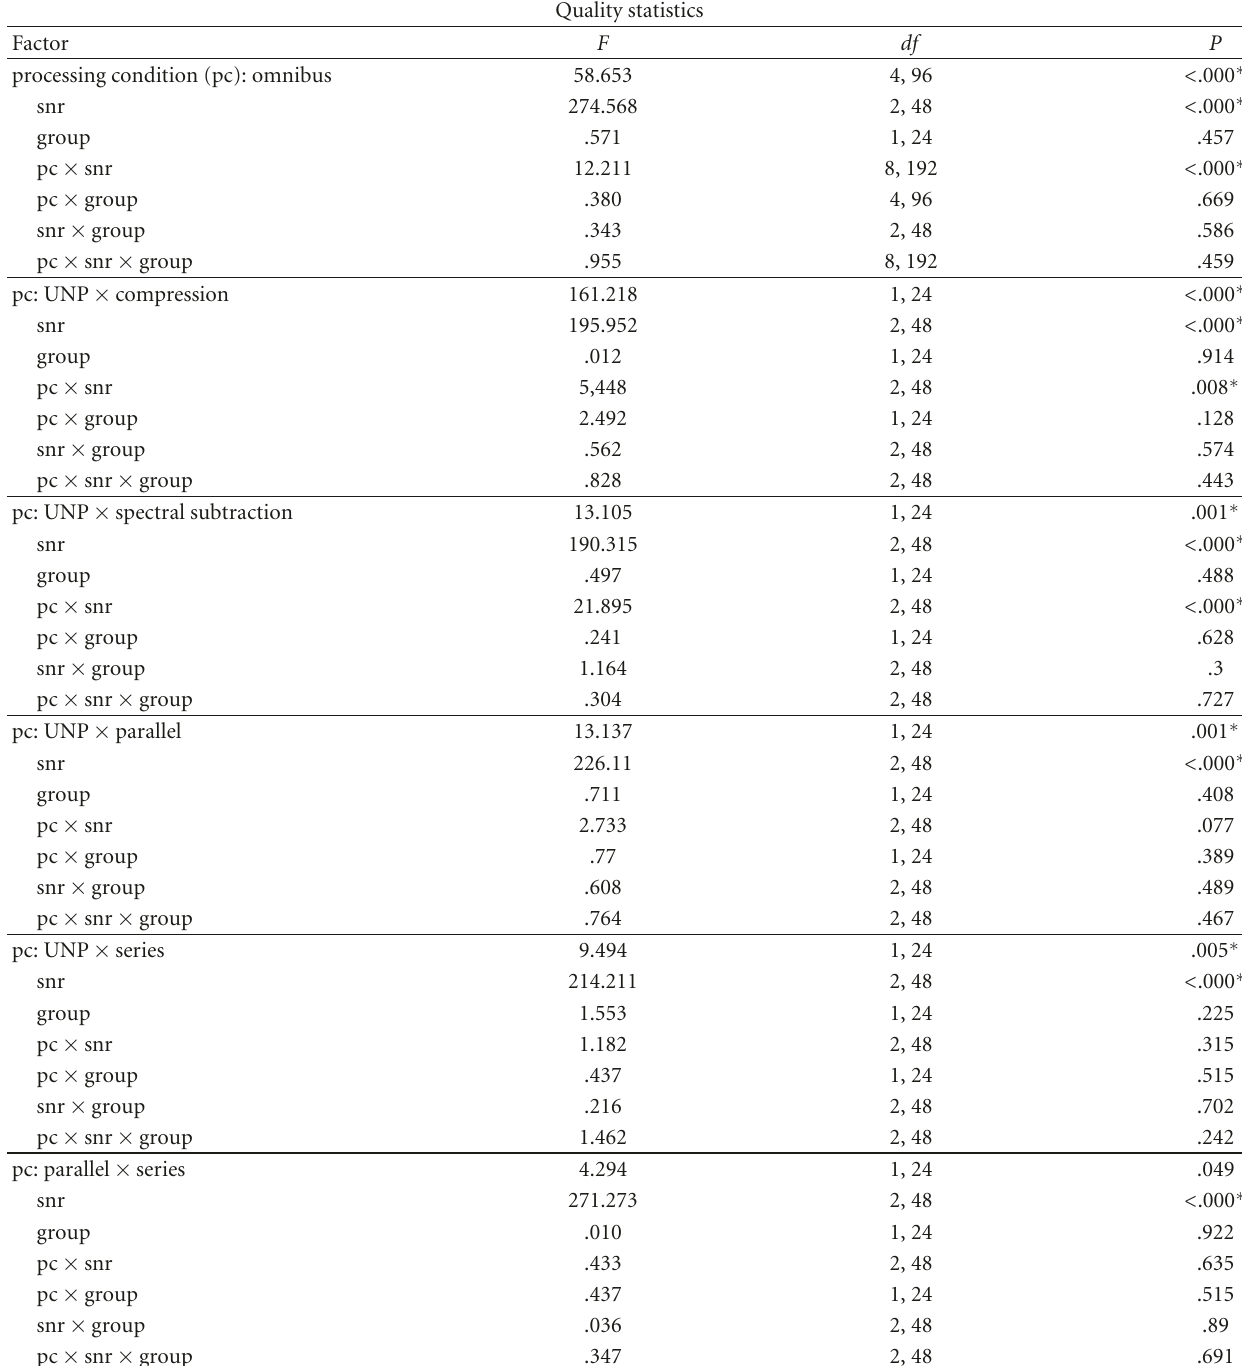
Table 4: Results of repeated measures ANOVA for quality scores. Statistical significance (marked with an ∗ ) is P < .01 due to Bonferroni